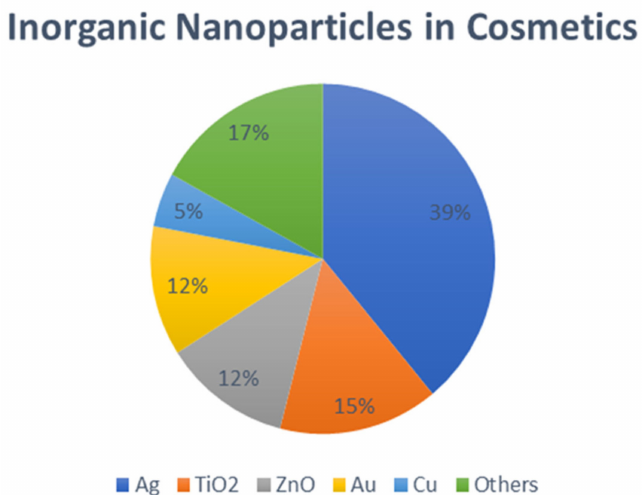
Figure 2. Proportions of different inorganic nanoparticles in cosmetics